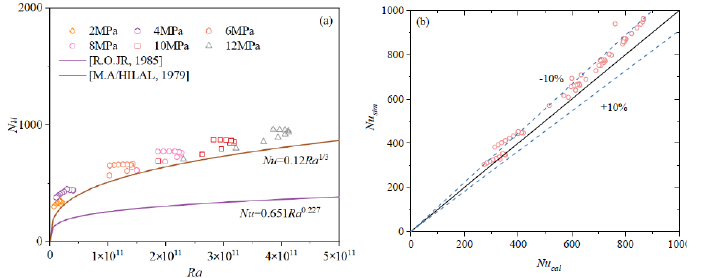
Figure 14. Heat transfer correlation ( a ) and comparison ( b ) of supercritical helium natural